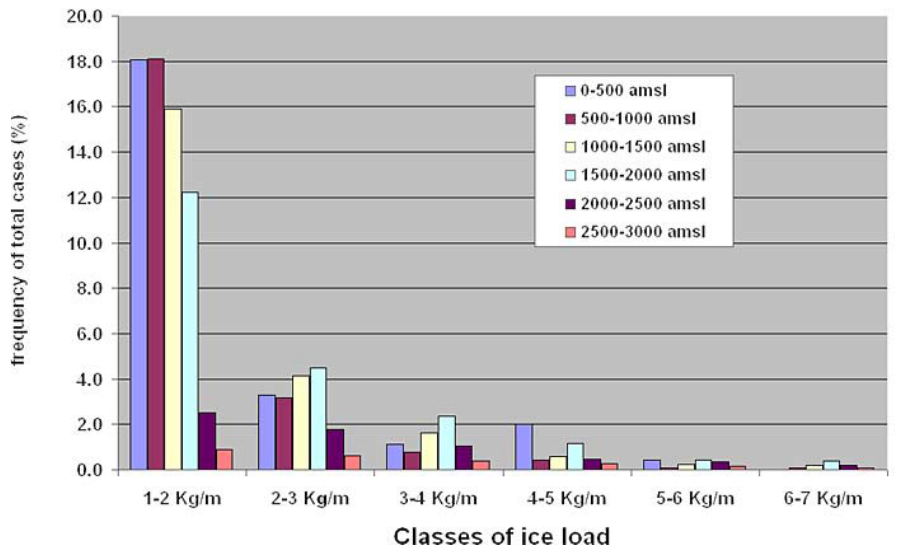
Fig. 13. As in Fig. 12, divided into ranges of altitude and ice